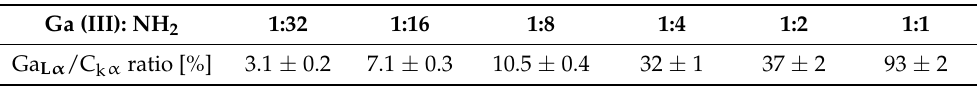
Table 2. Intensity ratios of Ga L α and C k α peaks of the EDX spectra of all investigated Ga (III)-CS